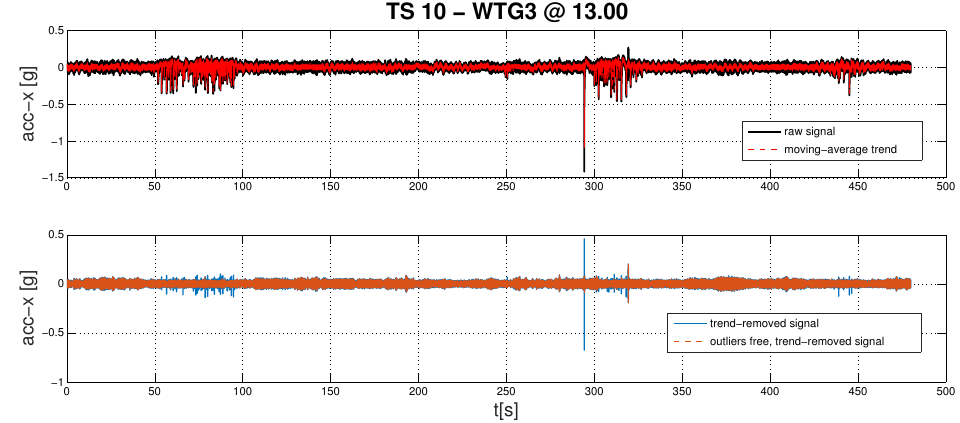
Figure 4. A sample time series of the raw and processed signal.